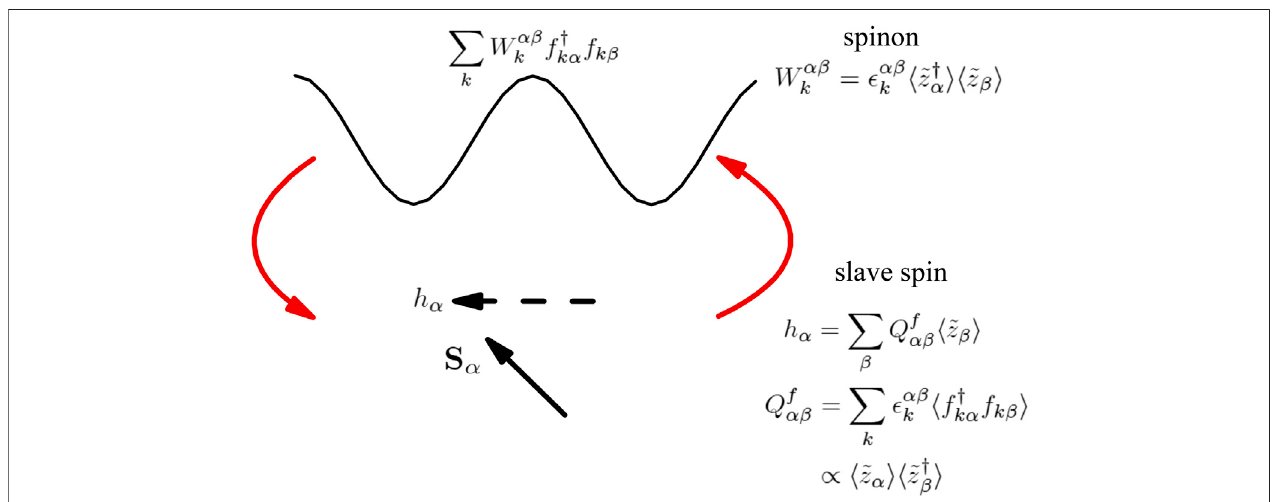
FIGURE3| Illustratingtheeffectoftheinterorbitalkinetichybridizationinthe U ( 1 ) slave-spintheory.Theblackcurveshowstheeffectivespinondispersion,whichis described by W αβ k f † k ασ f k βσ . (The physical spin index σ is suppressed in the fi gure legends.) Meanwhile, the slave-spin S α experiences a local fi eld, h α (cid:2) (cid:1) β Q f αβ 〈 ~ z β 〉 , where Q f αβ ∝ 〈 ~ z α 〉〈 ~ z † β 〉 . The red arrows indicate the self-consistency between W αβ k and h α , which results in a biquadratic interorbital coupling as shown in Eqs. 12 , 13 , adapted from